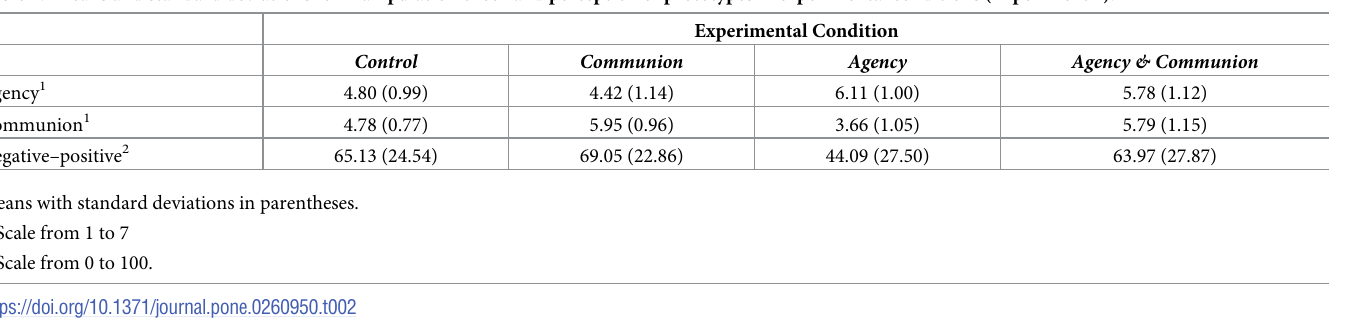
Table 2. Means and standard deviations for manipulation check and perception of prototypes in experimental conditions (Experiment 1).